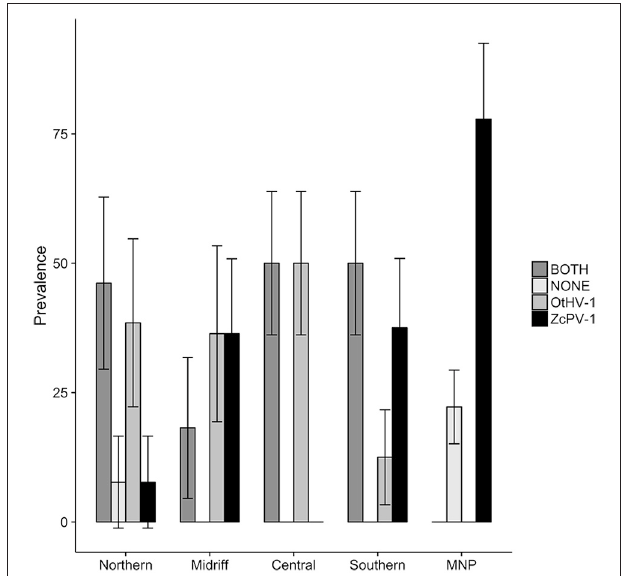
FIGURE 6 | Prevalence of infection by oncogenic viruses in the genital epithelium of California sea lions according to ecological regions within the Gulf of California and the Mexican North Pacific (MNP). ZcPV-1 infections were highest in the Mexican North Pacific followed by the midriff and southern Gulf of California, OtHV-1 infections were highest in the central region, followed by the northern and midriff regions, and concurrent infections by both viruses varied significantly among regions, following the pattern observed for OtHV-1. Bars = ±